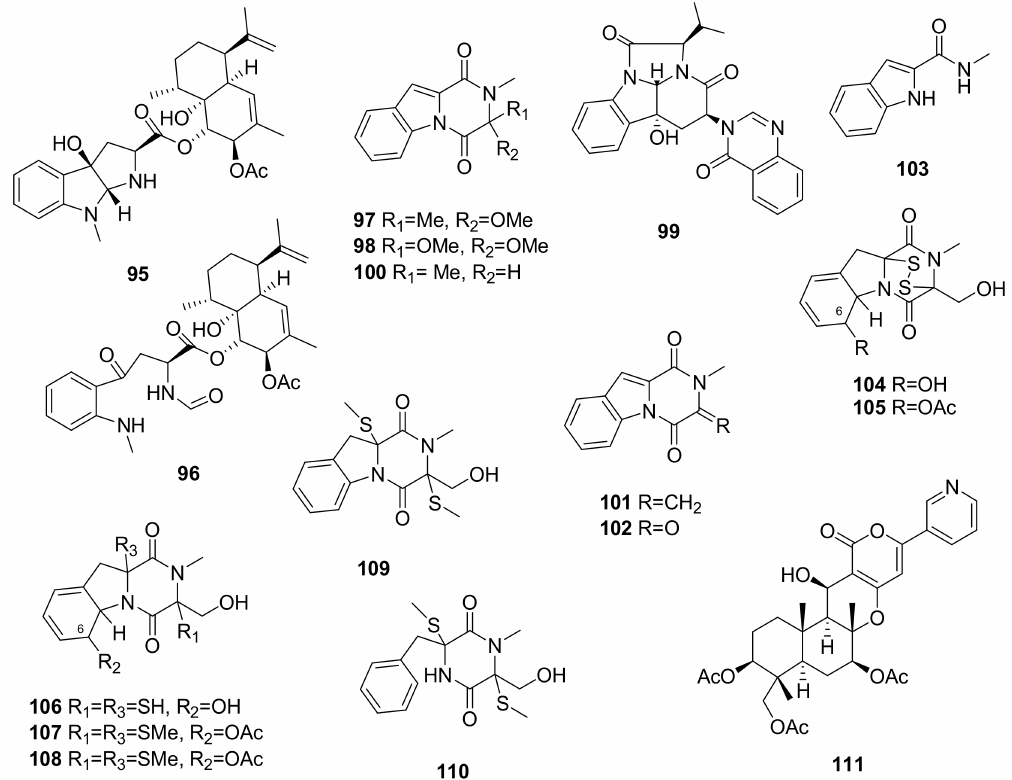
Figure 7. The structures of fischerindoline ( 95 ), eurochevalierine ( 96 ), neosartins A–C ( 97 – 99 ), 1,2,3,4-tetrahydro-2,3-dimethyl-1,4-dioxopyrazino[1–a]indole ( 100 ), 1,2,3,4-tetrahydro-2-methyl- 3-methylene-1,4-dioxopyrazino[1–a]indole ( 101 ), 1,2,3,4-tetrahydro-2-methyl-1,3,4-trioxopyrazino